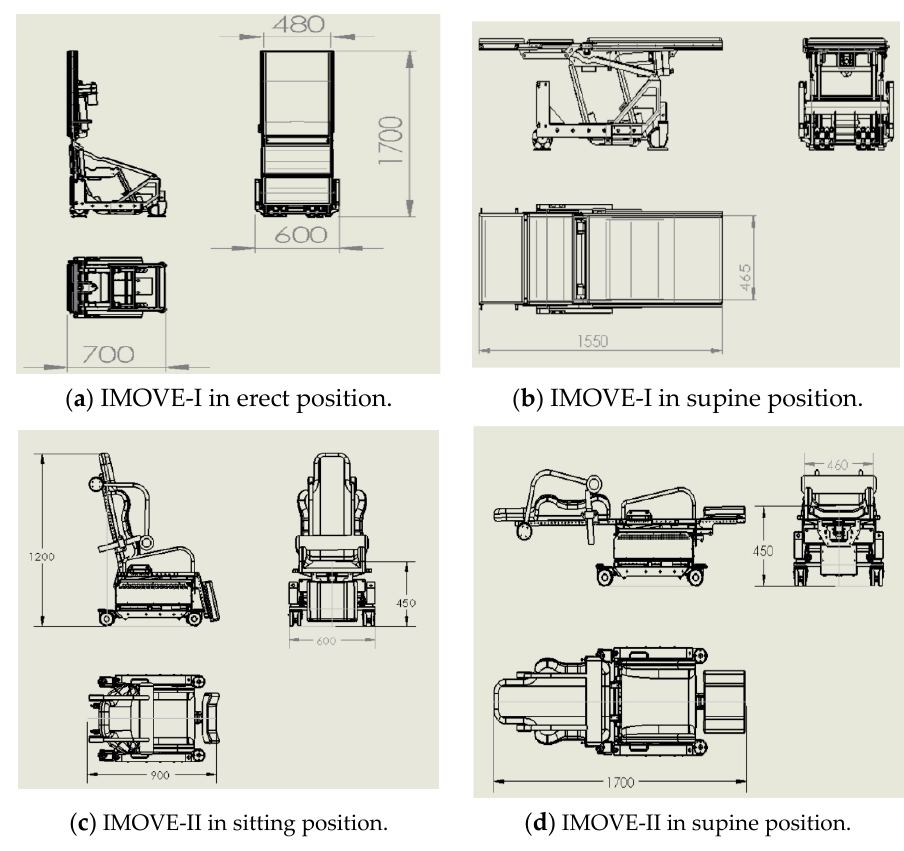
Figure 2. Dimension of IMOVE-I and IMOVE-II in mm. ( a ) IMOVE-I in the erect position. ( b ) IMOVE-I in the supine position. ( c ) IMOVE-II in the sitting position. ( d ) IMOVE-II in the supine position.